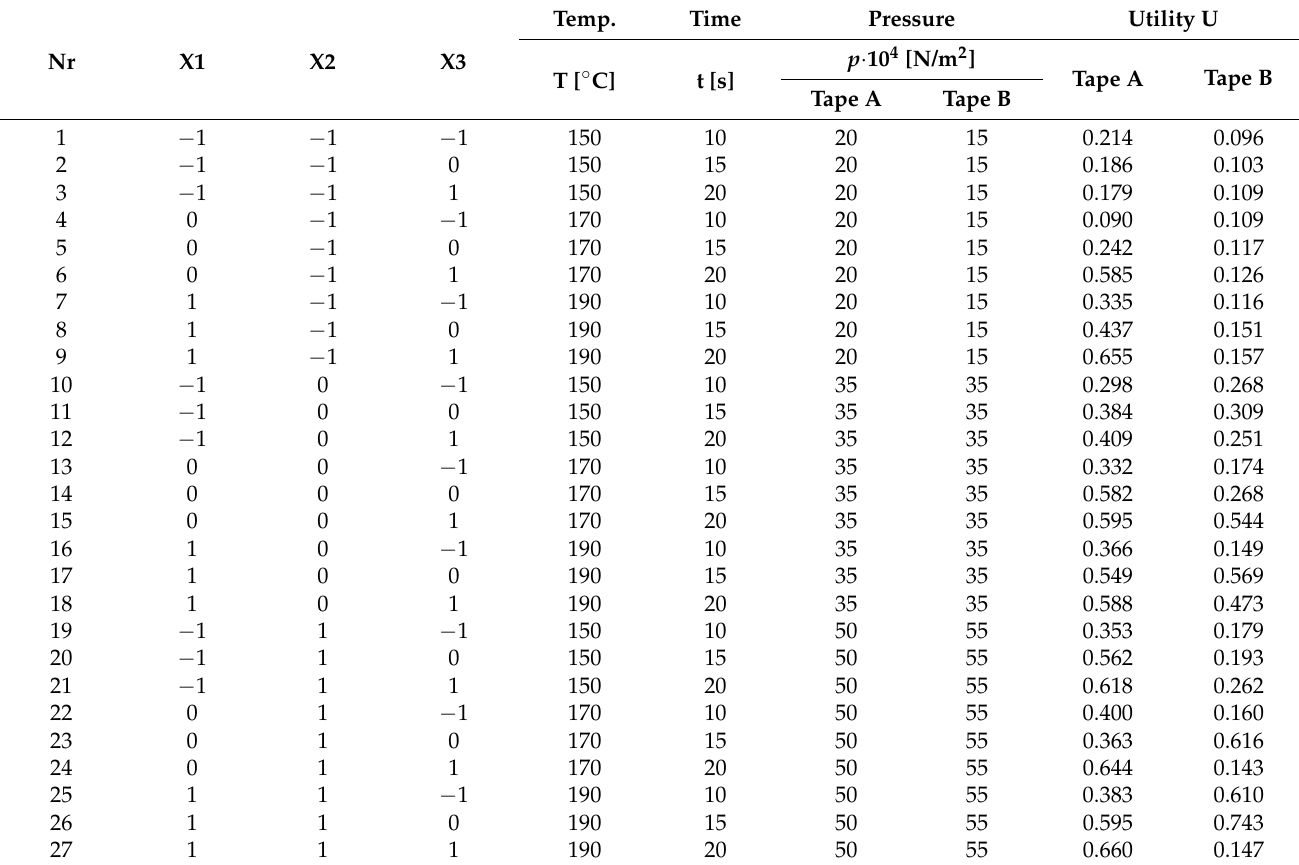
Table 3. Influence of lamination process parameters on value of utility function for seams A and B.